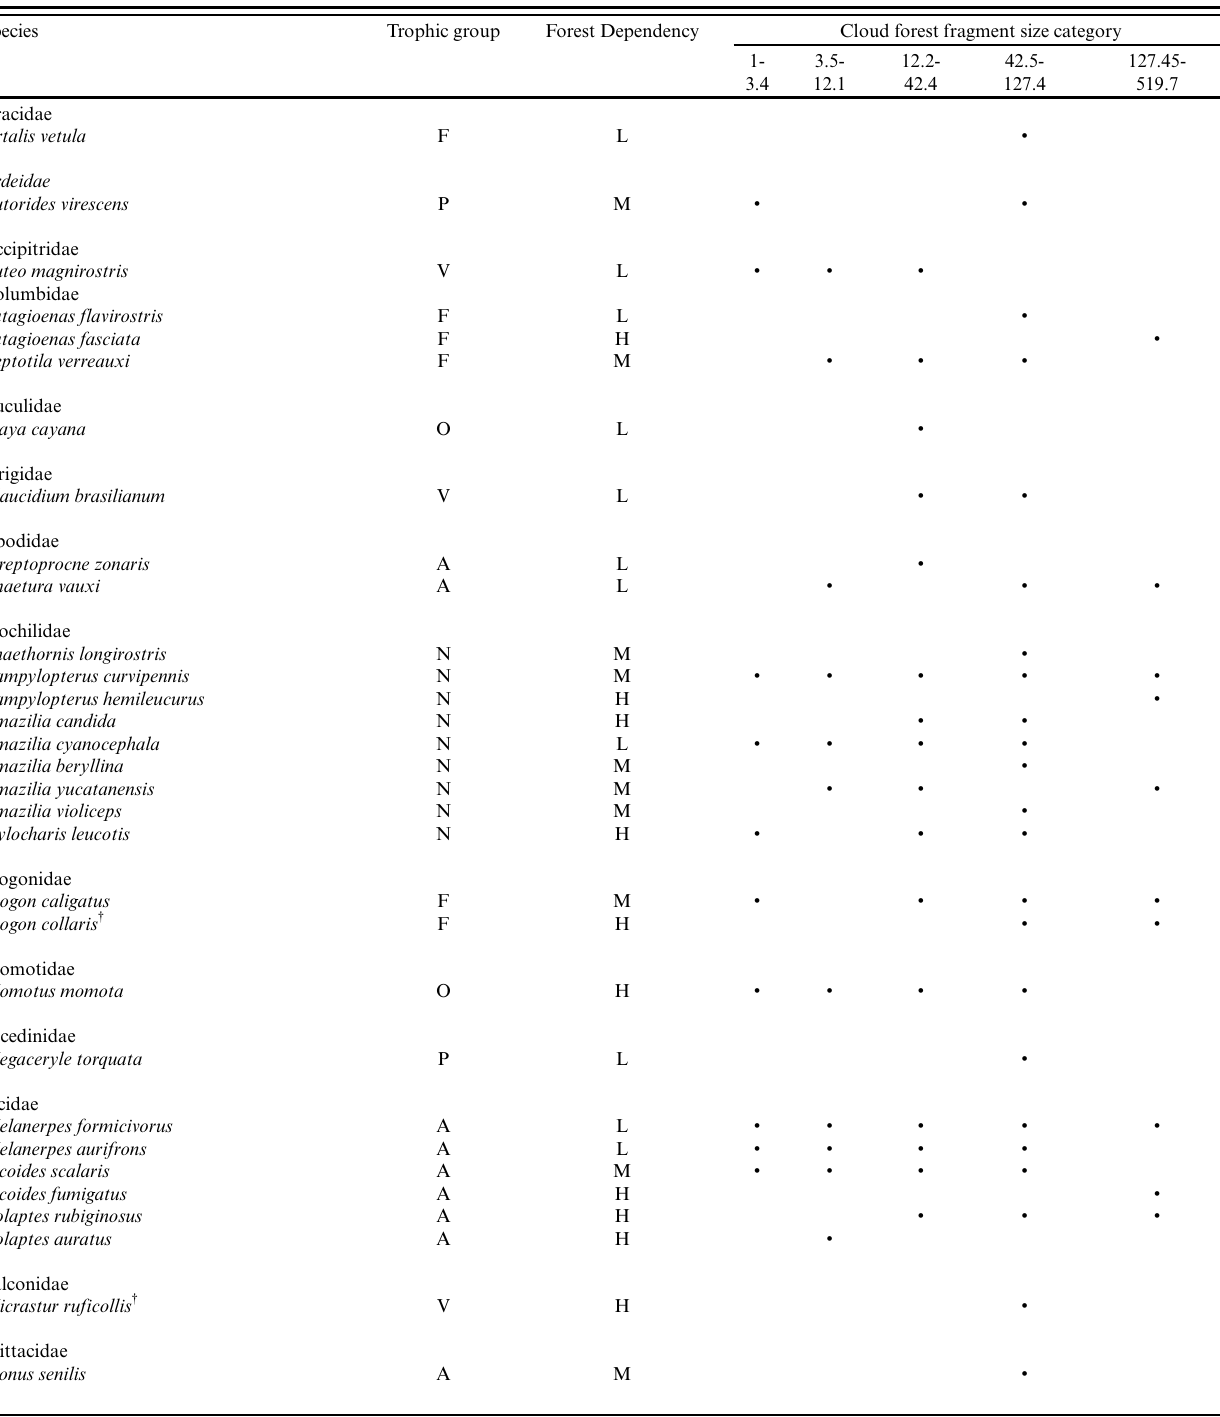
Table 1 . Resident landbird species recorded in each cloud forest fragment size category in central Veracruz, Mexico. Foraging guild: F indicates fruit; N, nectar; A, arthropods; V, vertebrates; O, omnivore; G, grain/seeds; P, fish. Forest dependency: H indicates high; M, moderate; L, low. † represent species protected under Mexican wildlife